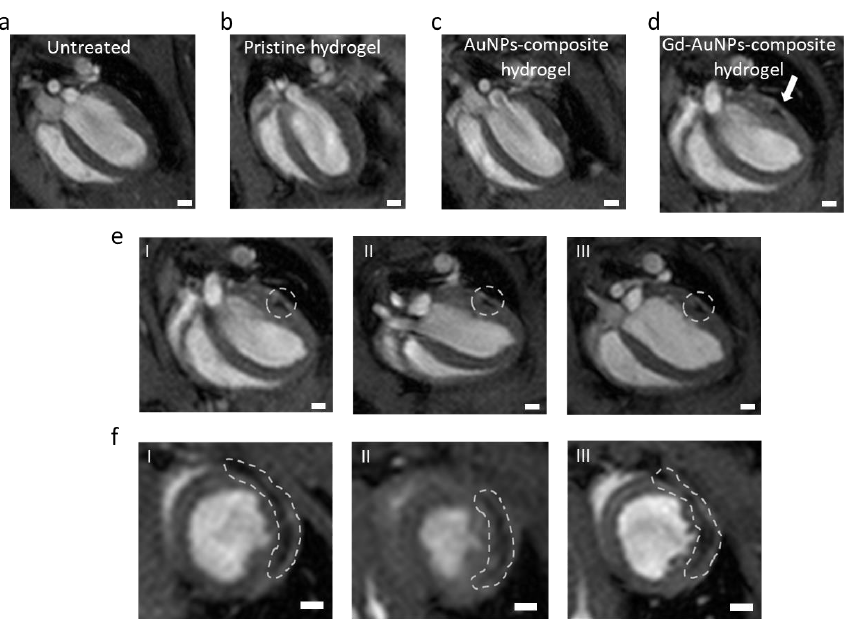
Figure 6. MRI imaging of the heart. ( a – d ) MRI images for ( a ) untreated, ( b ) pristine hydrogel-, ( c ) AuNP composite hydrogel-, and ( d ) Gd-AuNP composite hydrogel-treated mice, 6 weeks post IRI. The white arrow in ( d ) indicates the location of the Gd-AuNP composite hydrogel (black area), which was not observed in all other treatments. ( e , f ) MRI analysis monitoring the location of Gd-AuNP composite hydrogel (dashed area) over time. ( e ) SAX (short axis slices) and ( f ) LAX (long axis slices) at (I) 1 week, (II) 4 weeks, and (III) 6 weeks post IRI; scale bar = 1 mm.